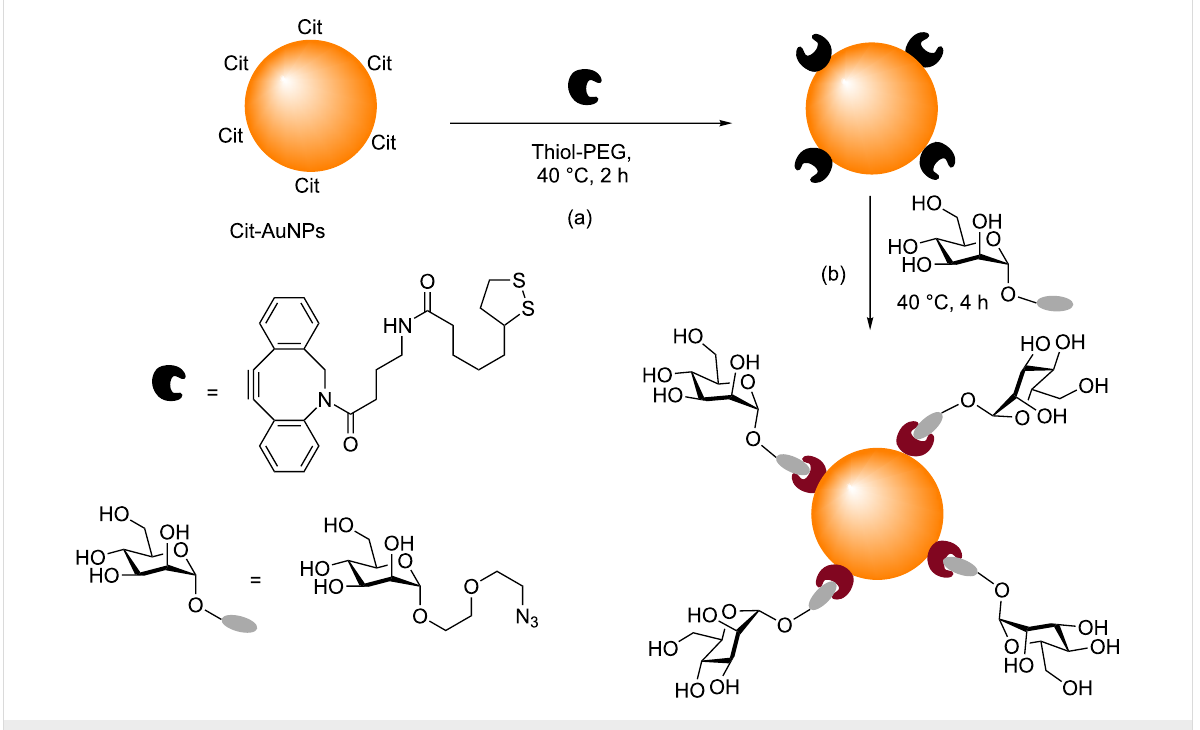
Scheme 12: Synthesis of (a) cyclooctyne-functionalized AuNPs and (b) GAuNPs using SPAAC